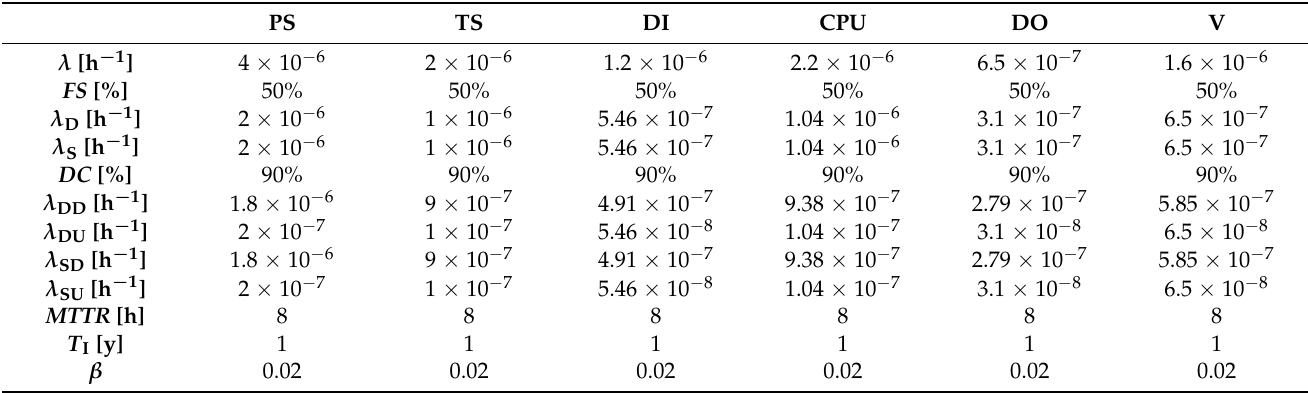
Table 10. Reliability data.